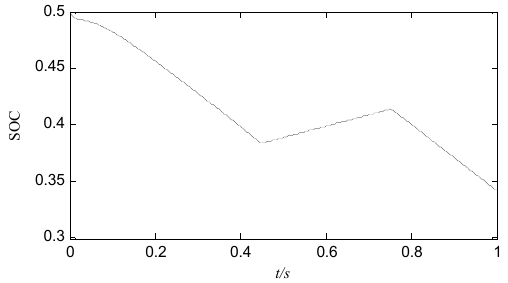
Figure 23. The curves of battery state of charge (SOC).